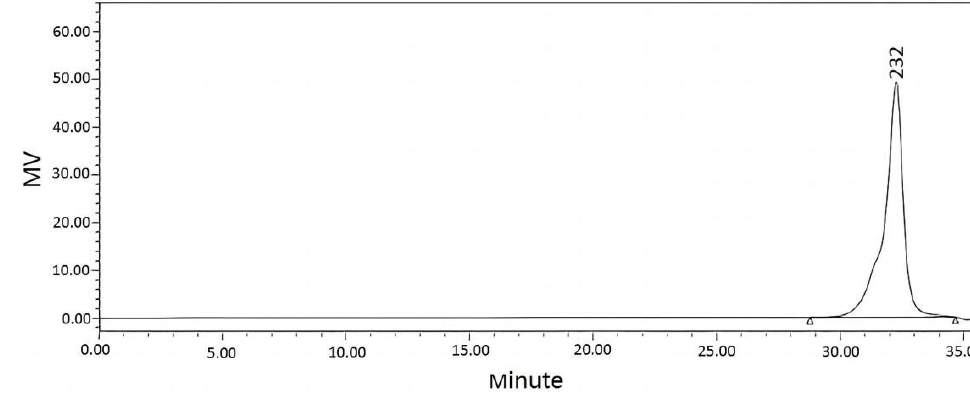
Figure 7. Mass spectrogram of benzoxazine (eugenol) .